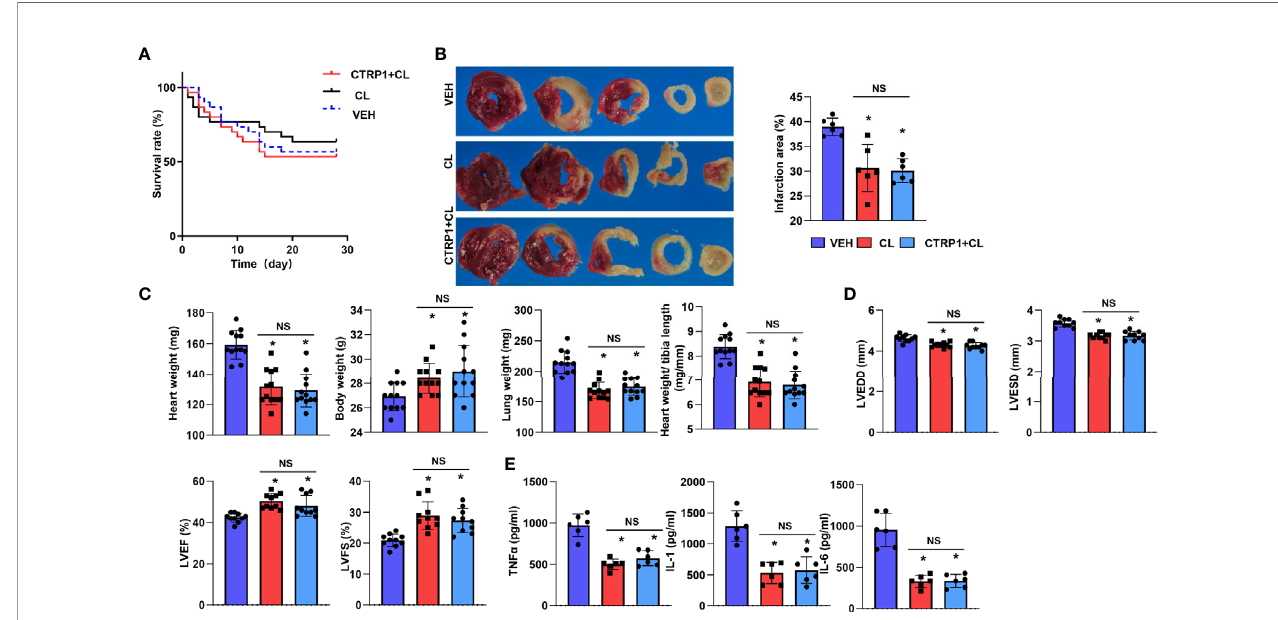
FIGURE 7 | Macrophage depletion reduces the effect of CTRP1 in vivo. (A) The survival rate of mice receiving clodronate liposome (CL) injection and the human recombinant CTRP1 protein at 28 days post MI (n=30 per group). (B) TTC staining and quanti fi cation of the infarct area (n=6). (C) Heart, body, and lung weights of